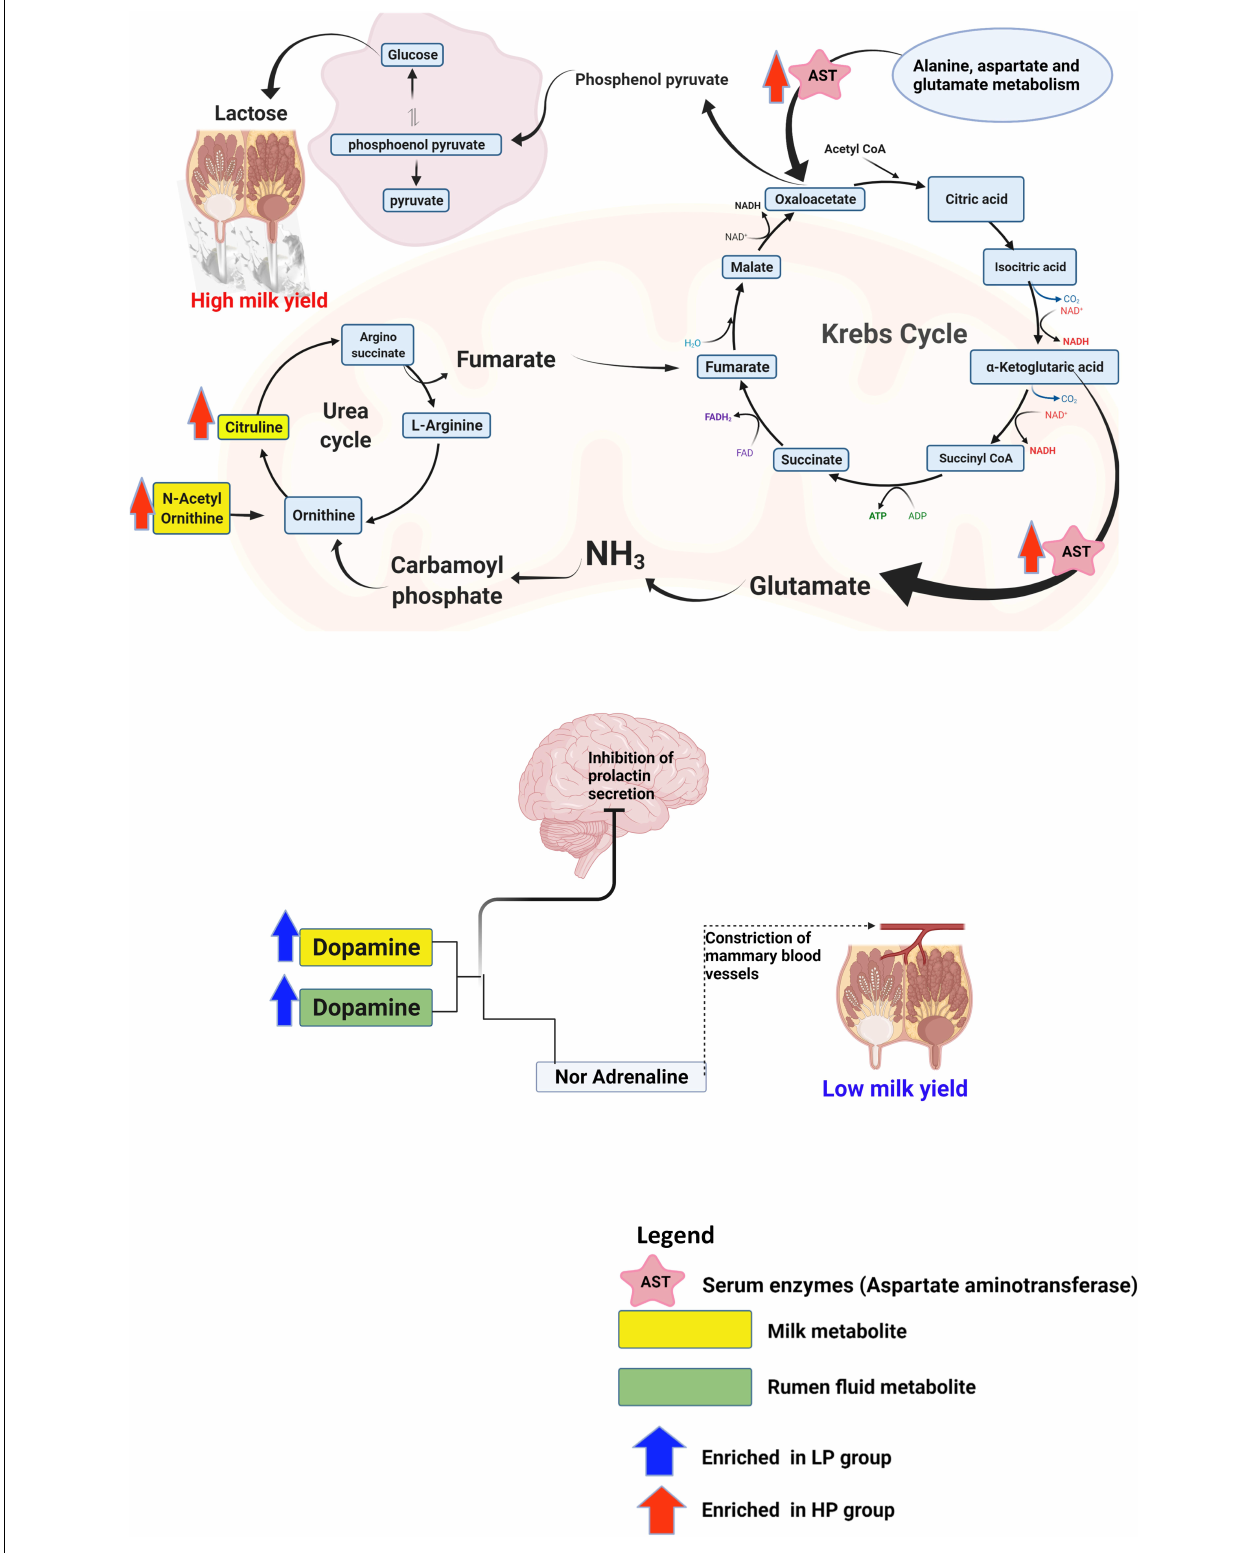
FIGURE 7 | Schematics of the metabolic mechanism underlying the disparity in milk yield between the HP and LP groups. This figure was created using Biorender.com.